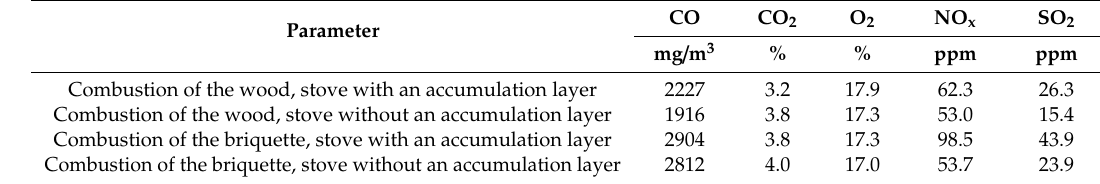
Table 1. The average emissions of CO, CO 2 , O 2 , NO x and SO 2 during wood and briquette combustion. CO CO 2 O Parameter